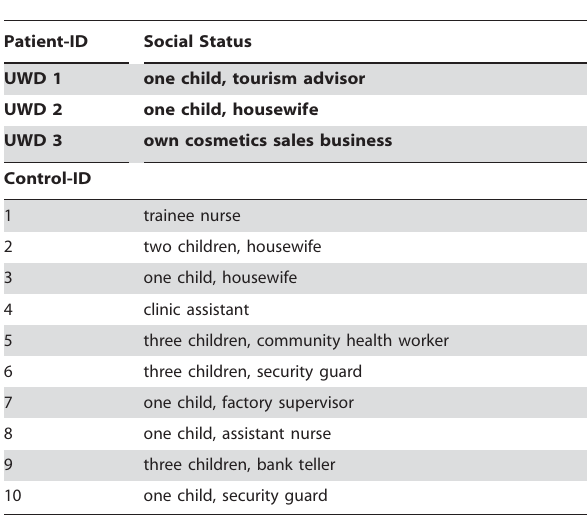
Table 1. Social and occupational status of the